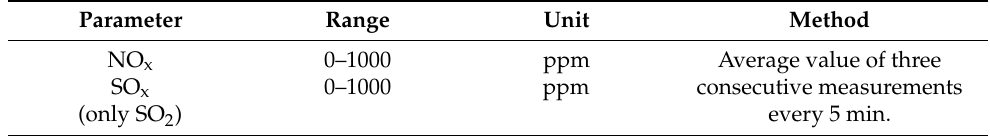
Table 4. NIER air pollution process test method